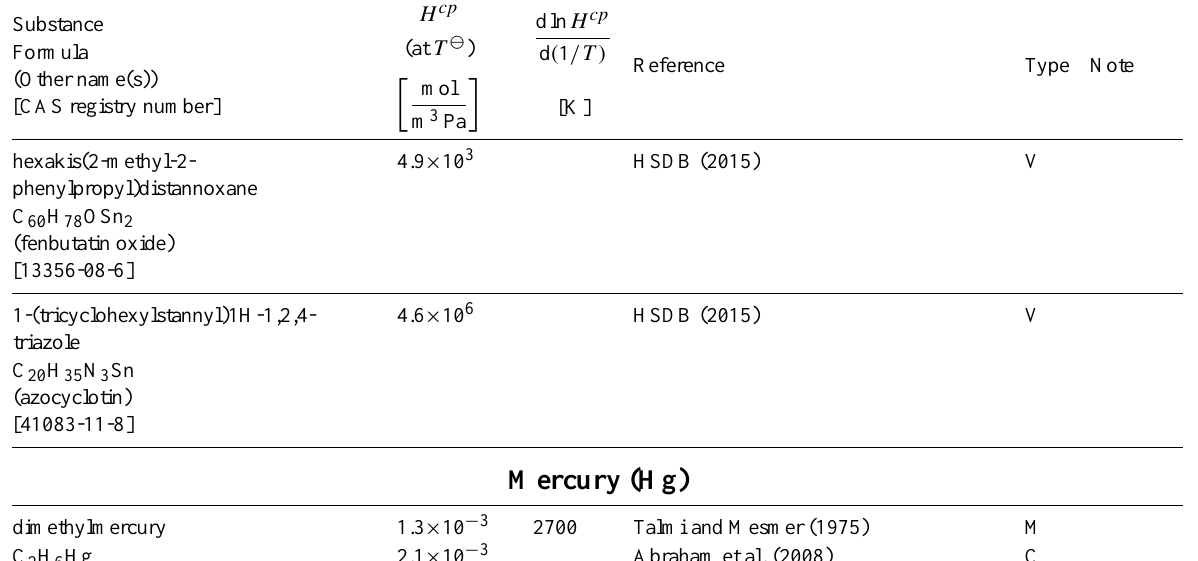
Table 6: Henry’s law constants for water as solvent